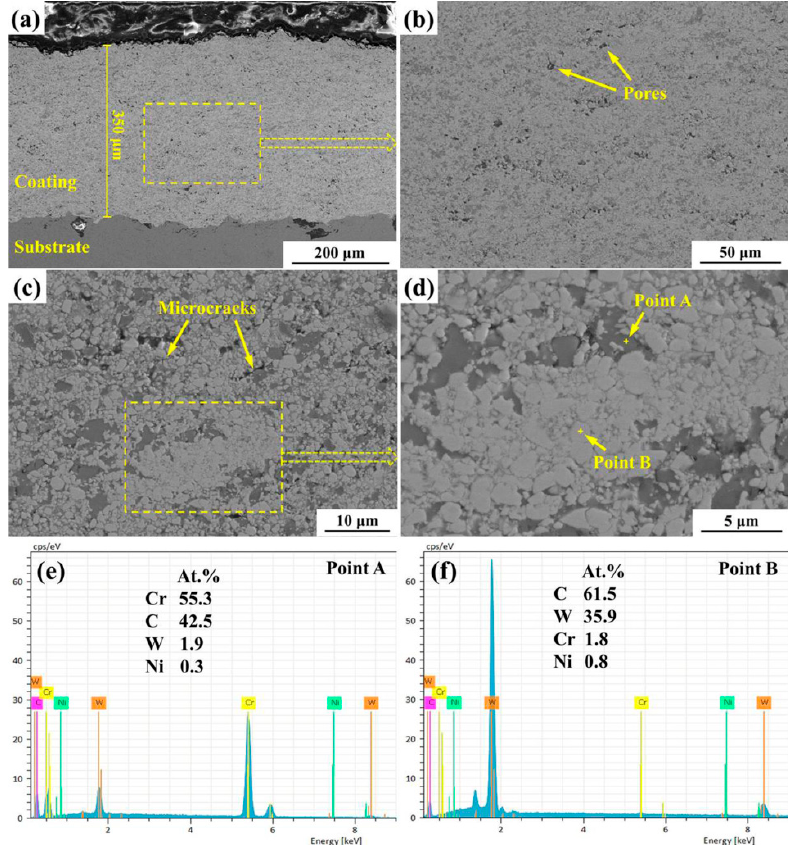
Figure 3. FE-SEM micrographs and EDS analysis of the as-sprayed coating: ( a – d ) typical cross-sectional microstructures, ( e ) EDS result of Point A, ( f ) EDS result of Point B.